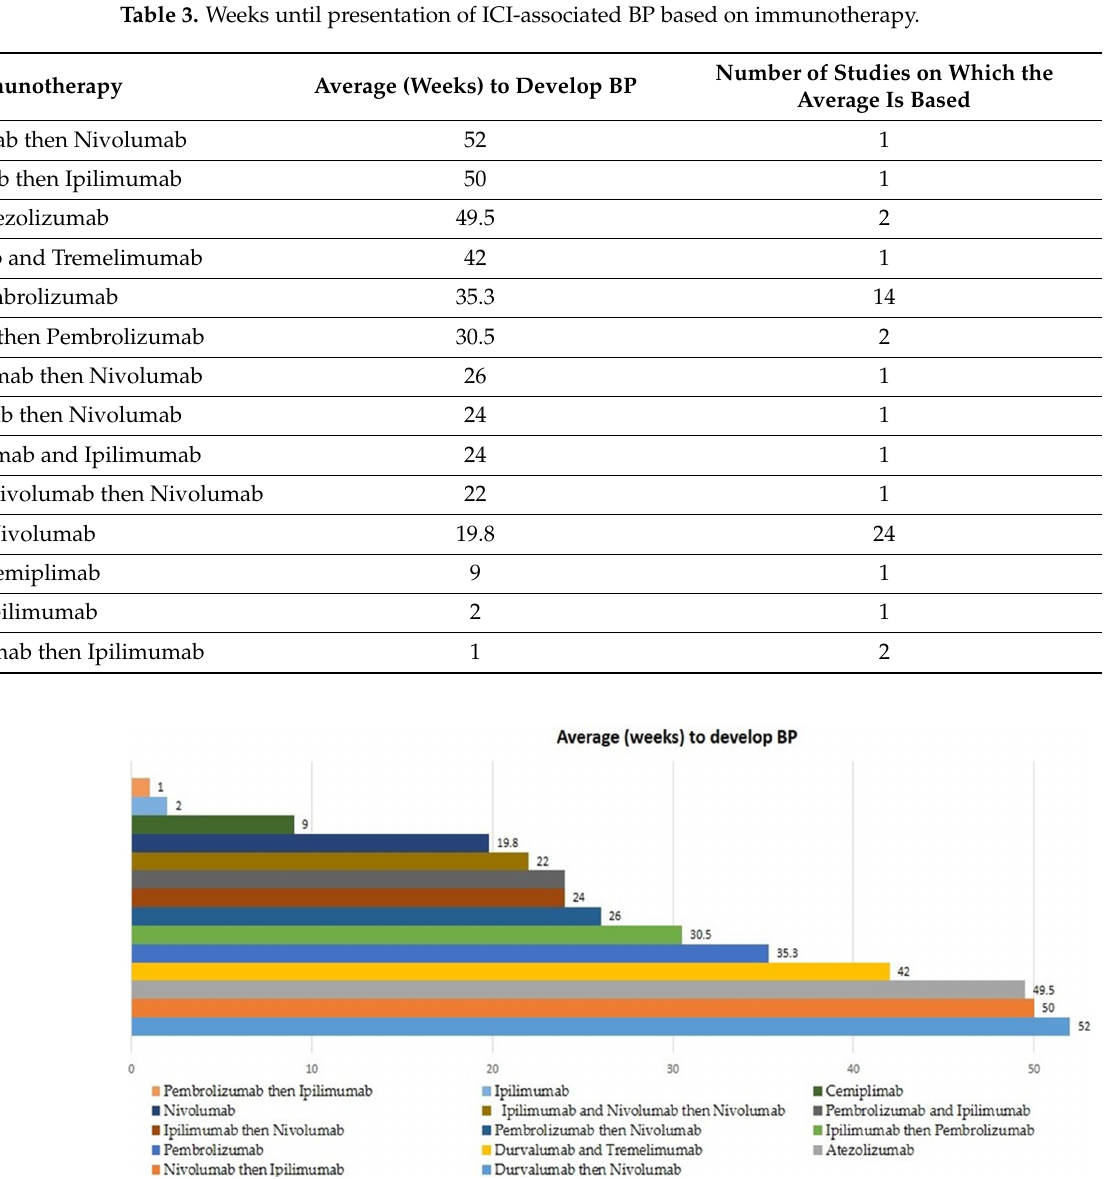
Table 3. Weeks until presentation of ICI-associated BP based on immunotherapy.